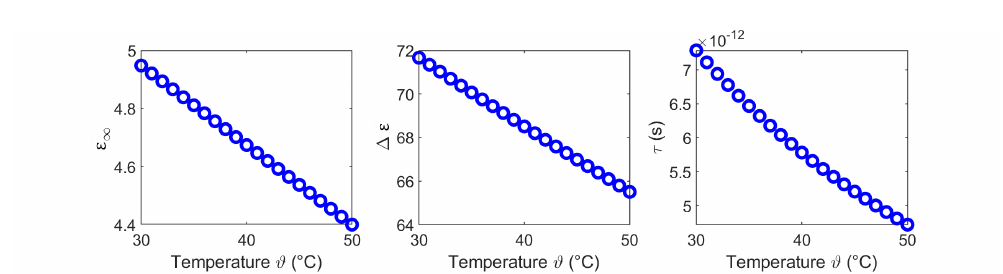
Figure 19. Temperature dependent model parameters of pure water corresponding to Kaatze